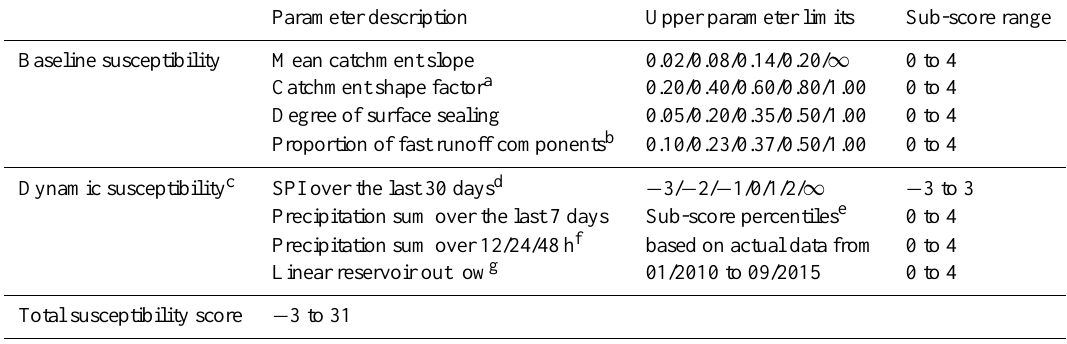
Table 2. ScoHM scoring system.